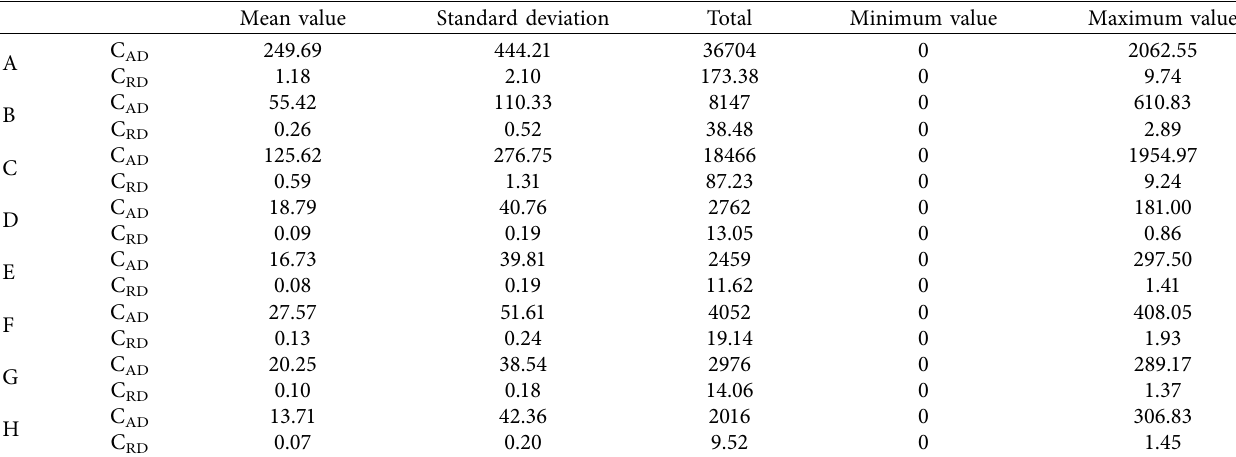
Table 2: Social network betweenness centrality of professional athletes.